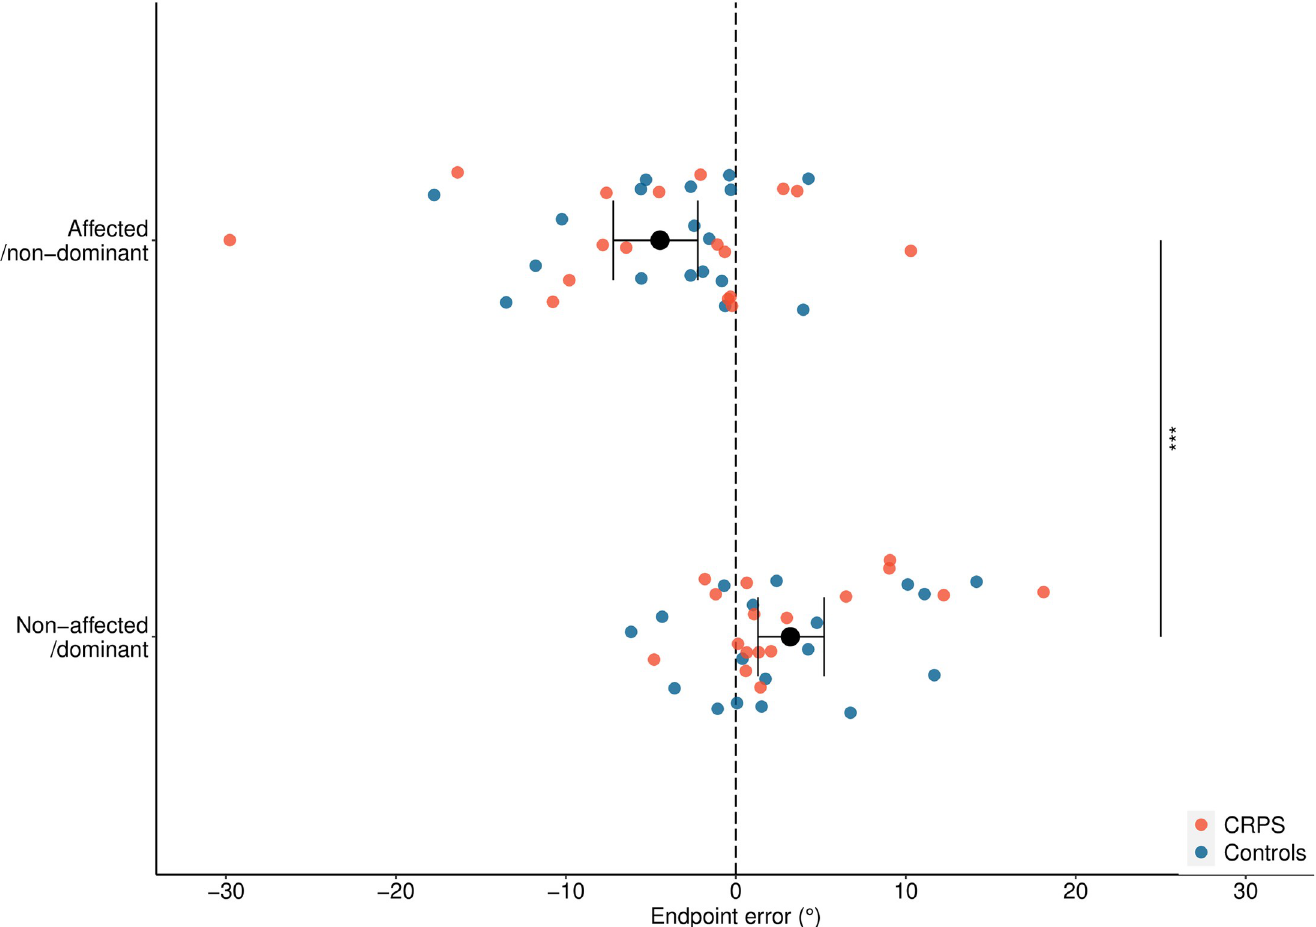
Fig 1. Manual straight ahead endpoint errors. Mean endpoint errors in degrees are presented split by Side of Body (affected/non-dominant, non-affected/dominant), for participants with CRPS (orange dots, n = 17, M affected = -4.78˚, SD = 8.99; M non-affected = 3.42˚, SD = 5.77), and for control participants (blue dots, n = 18, M non- dominant = -4.16˚, SD = 5.85, M dominant = 3.01˚, SD = 5.79). Black dots show mean values for each Side of Body, with bootstrapped 95% confidence intervals (error bars). A negative score indicates errors made towards the affected/non-dominant side. ��� p < 0.001.